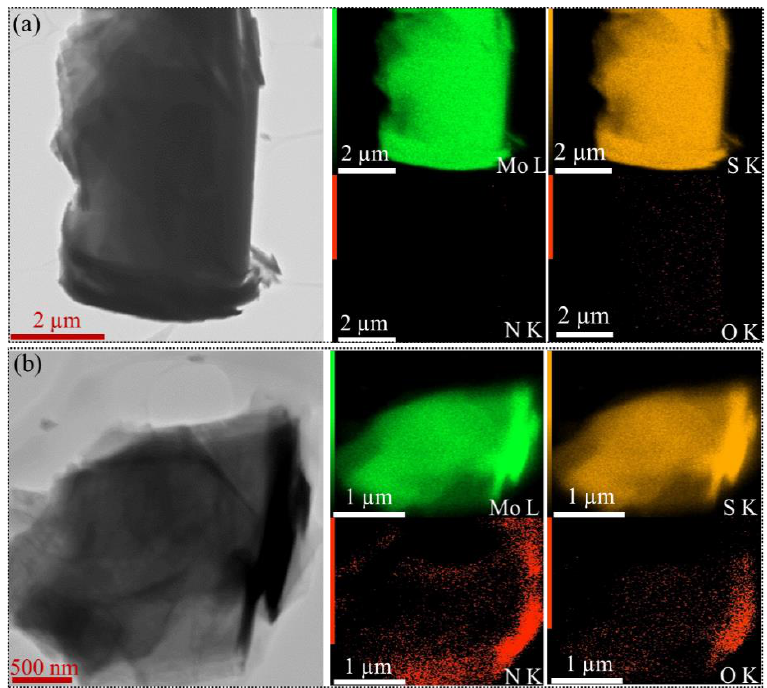
Figure 6. TEM images and elemental mapping for ( a ) bulk MoS 2 and ( b ) F-MoS 2 nanosheets.